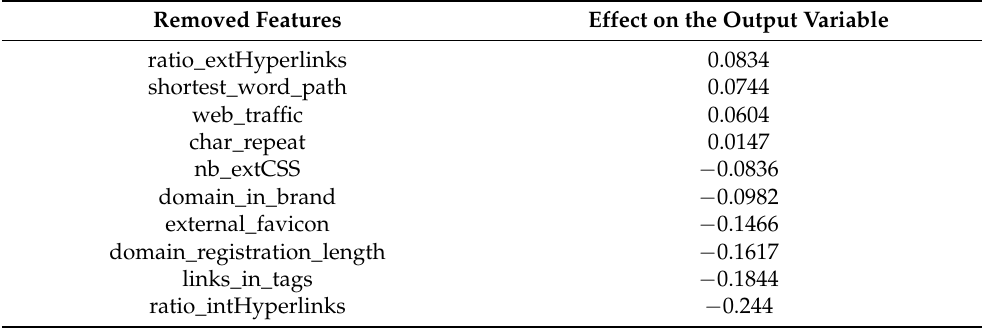
Table 6. List of removed features using PPS and their effect on the output variable on dataset 2.